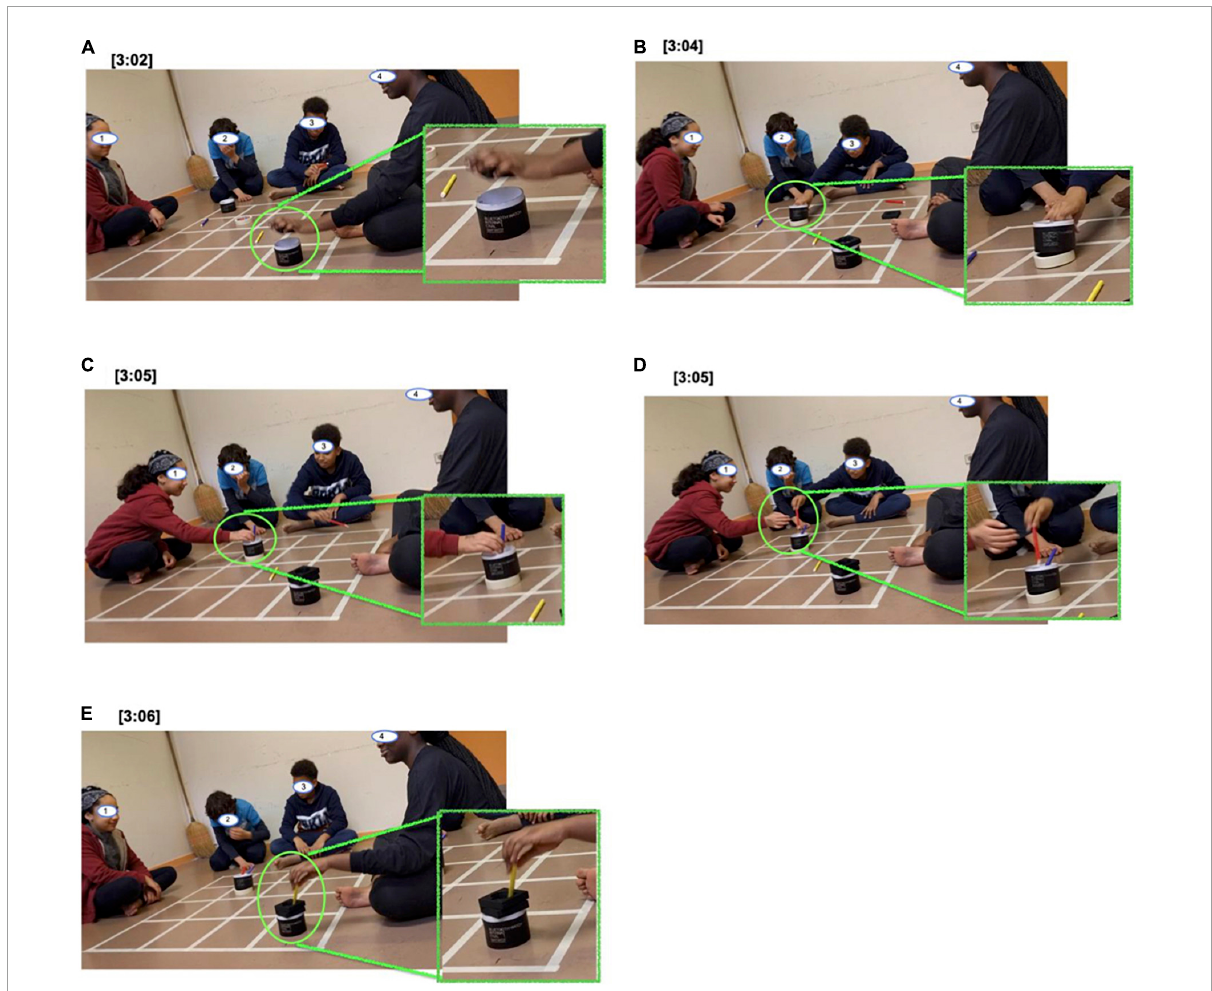
FIGURE5 Example of an intentional suggestion. (A) Player 4 places the flat square on top of one of the round boxes. (B) Player 3 places the other round box on top of the roll of tape. (C) Player 1 places a pen inside the round box. (D) Player 3 puts a second pen in the same box. (E) Player 4 places the last pen in the other round